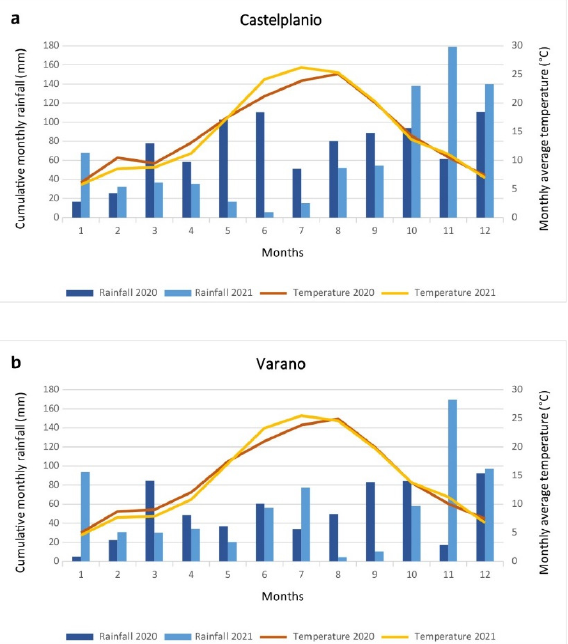
Figure 2. Climatic conditions in the two vineyards under study in 2020 and 2021. ( a ) Castelplanio vineyard, ( b ) Varano vineyard. vineyard, ( b ) Varano